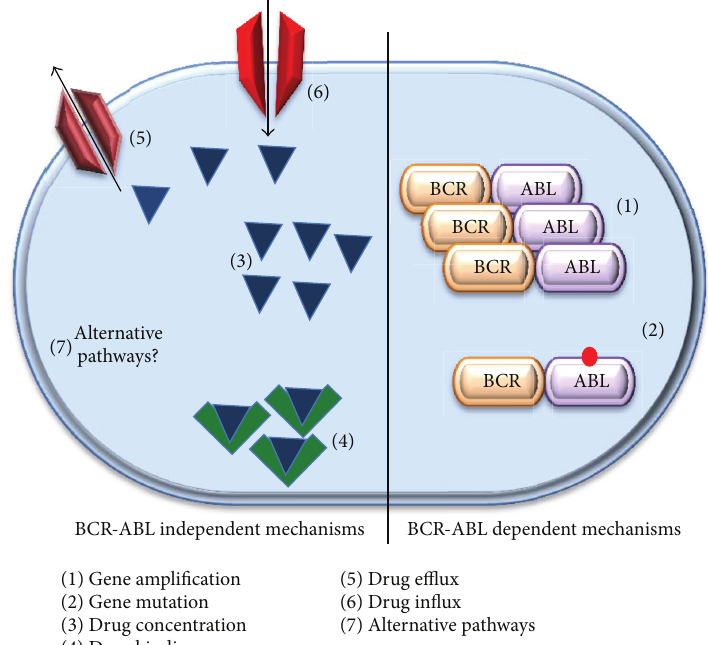
Figure 3: Mechanisms of CML cells resistance to TKI. BCR-ABL dependent mechanisms include (1) duplication or overamplification of the BCR-ABL oncogene that might lead to an elevated ABL kinase activity or (2) BCR-ABL mutations that affect TKI binding. BCR-ABL independent mechanisms deal with complications such as drug concentration (3), sequestration of imatinib in the plasma by the serum protein acid glycoprotein (AGP) or drug binding (4), increased expression of the P-glycoprotein (Pgp) efflux pump or drug efflux (5), and reduced expression of the organic cation transporter hOCT1 or drug influx (6). Other mechanisms that play a role in TKI resistance and CML progression include activation of alternative signaling pathways downstream of BCR-ABL